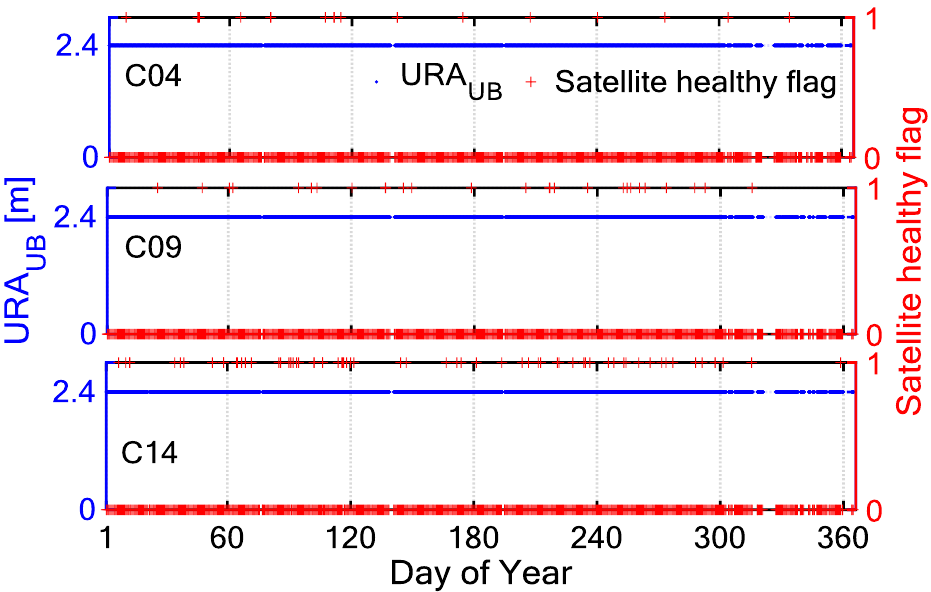
Figure 1. Time series of User Range Accuracy (URA) and satellite healthy flag (0: health, 1: anomaly) from BeiDou Navigation Satellite System (BDS) broadcast ephemeris for the C04 ( top ), C09 ( middle ), and C14 ( bottom ) during the year 2017.